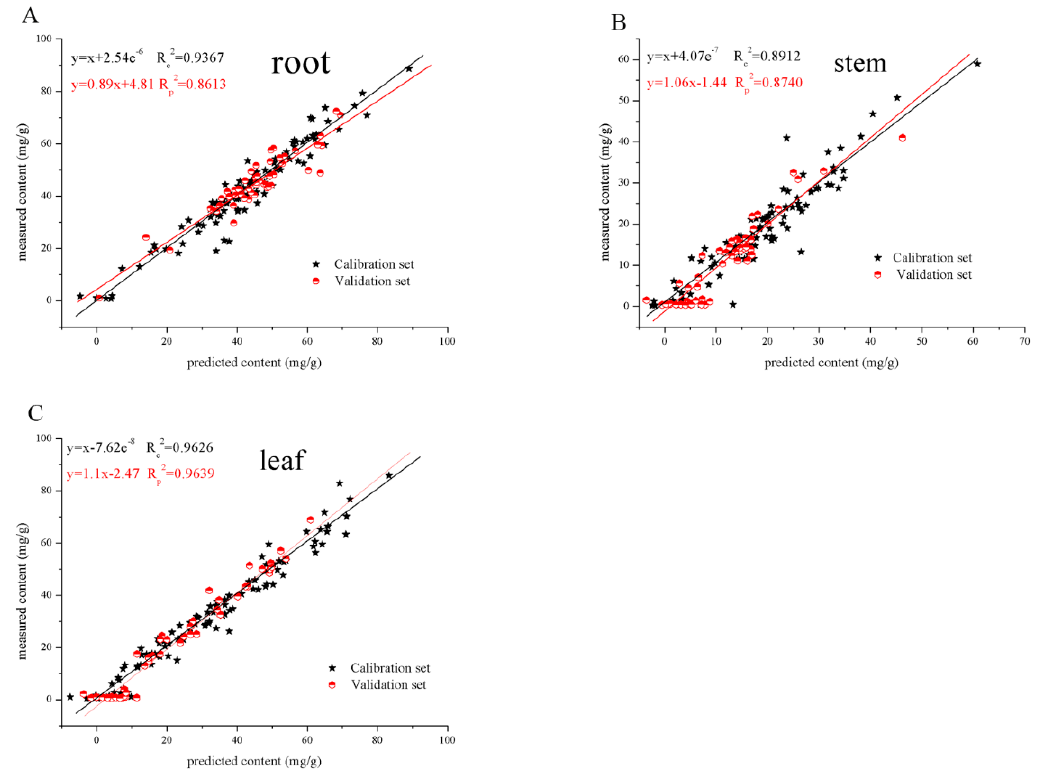
Figure 7. The relationship between predicted and measured content for total secoiridoids in the root ( A ), stem ( B ) and leaf ( C ).